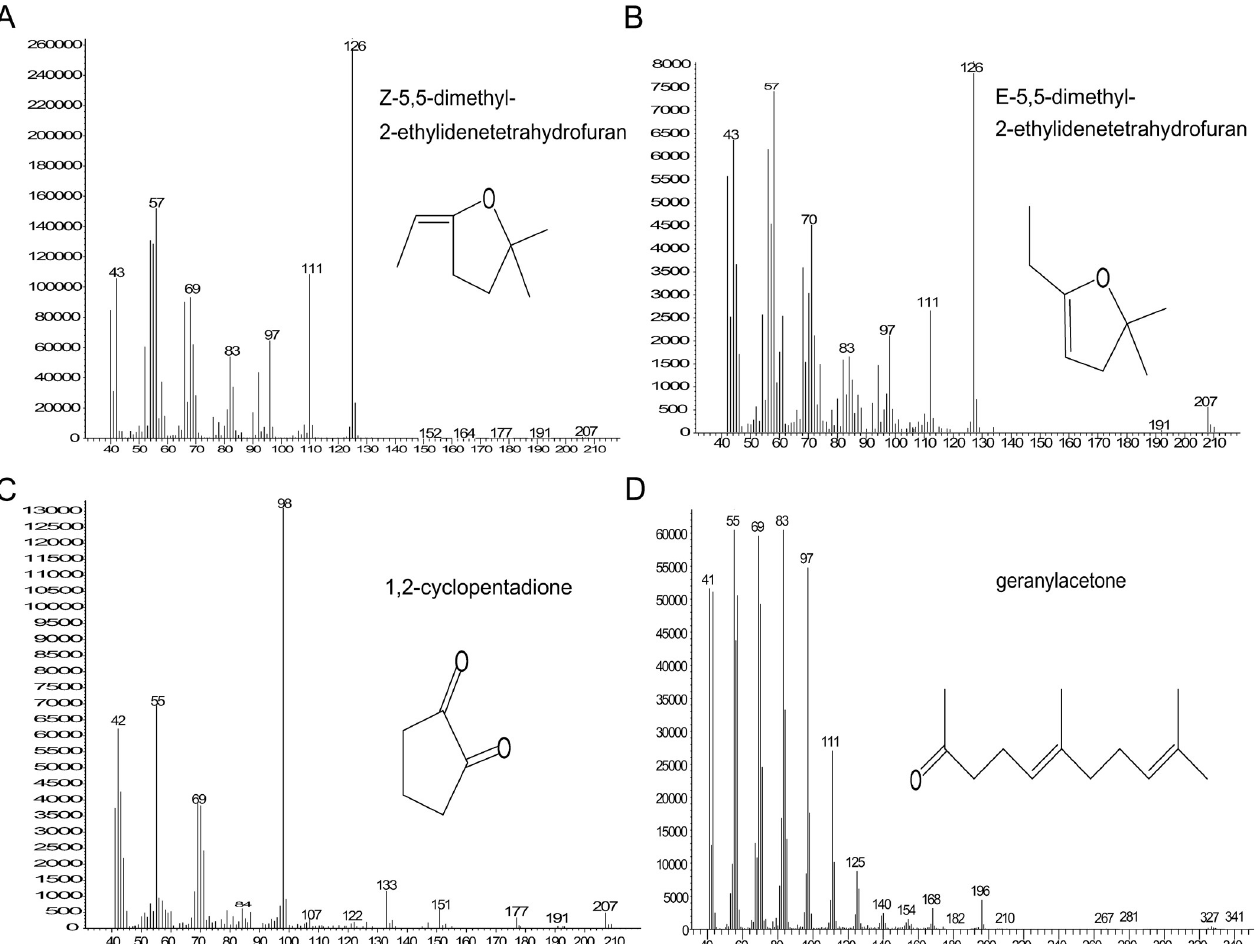
Fig 5. High loading compounds on nest PC1 and their mass spectra (EI 70 eV). (A) Z-5,5-dimethyl-2-ethylidenetetrahydrofuran at retention time 7.98 min; (B) E-5,5-dimethyl-2- ethylidenetetrahydrofuran at retention time 9.38 min; (C) 1,2-cyclopentadione at retention time 10.85 min; (D) geranylacetone at retention time 43.93